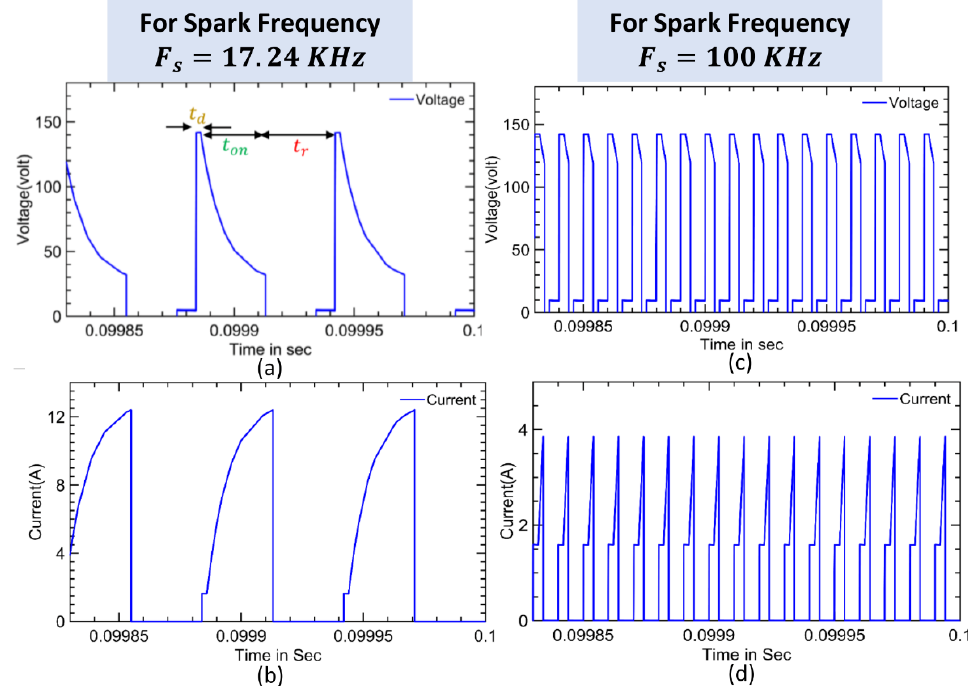
Figure 3. Gap voltage and current waveforms during the EDM process ( a , b ). For the spark frequency (F s ) = 17.24 KHz, and ( c , d ) for the spark frequency (F s ) = 100 KHz.